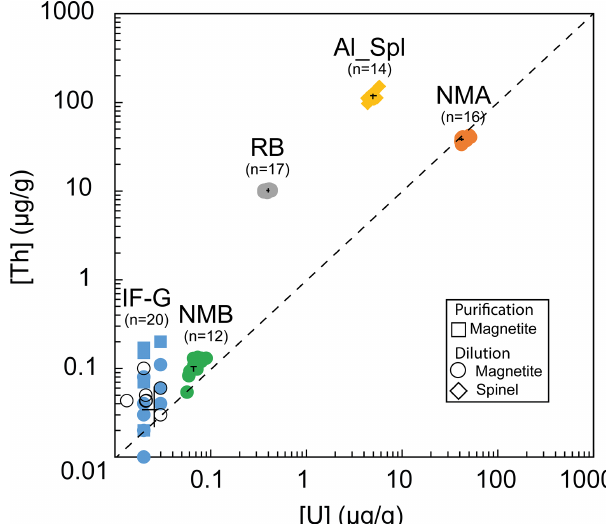
Figure 2. U and Th content obtained by wet chemistry and as- sociated mean value and standard deviation (black cross); black empty circles represent IF-G results from the literature (Govin- daraju, 1995; Dulski, 2001; Bolhar et al., 2004, 2015; Kamber et al., 2004; Guilmette et al., 2009; Parks et al., 2014; Viehnmann et al.,